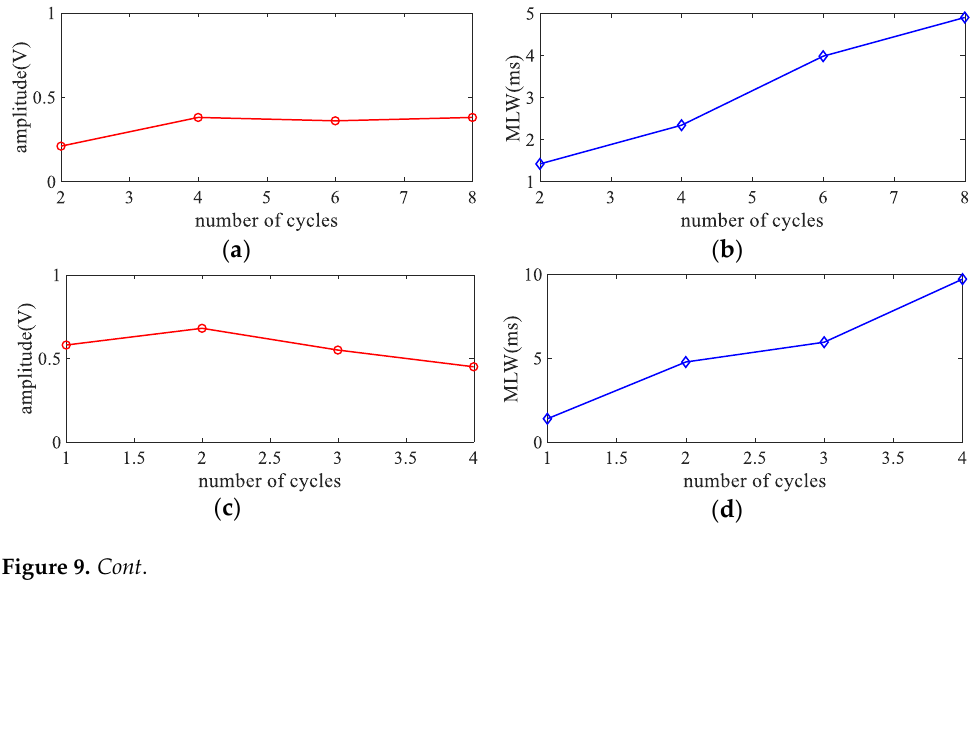
Figure 8. Results analysis of encoding excitation by 63 − bit Kasami sequence under different carrier cycles, ( a – d ) the corresponding received signals, ( e – h ) the corresponding decoding results.